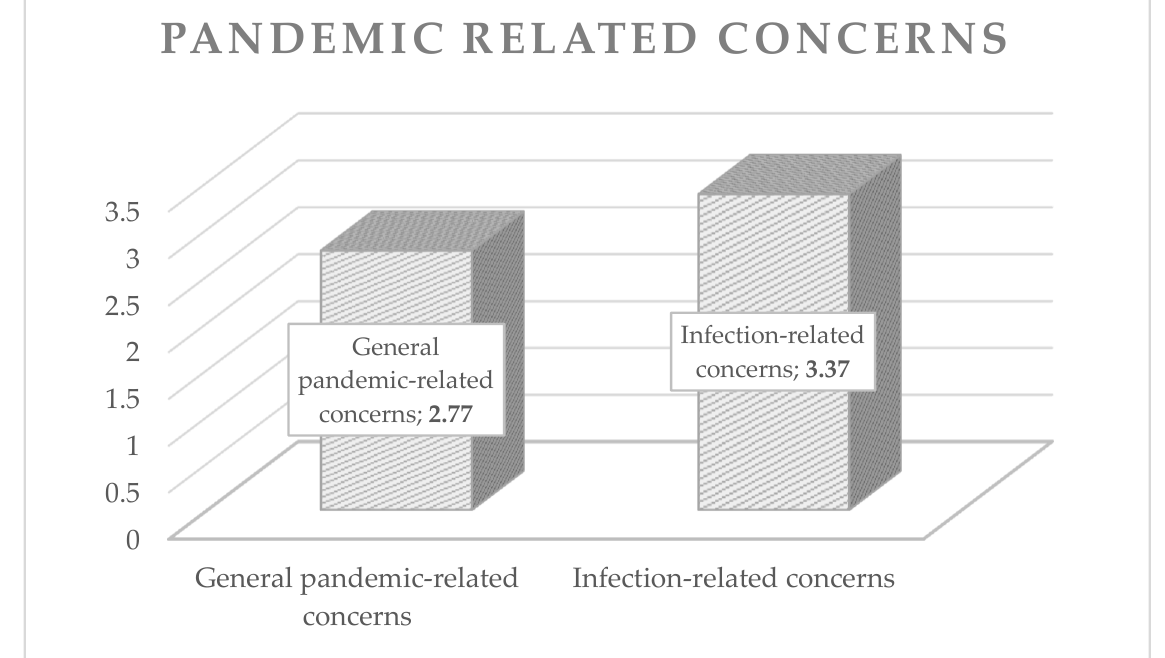
Figure 1. Mean values of pet-related concerns.